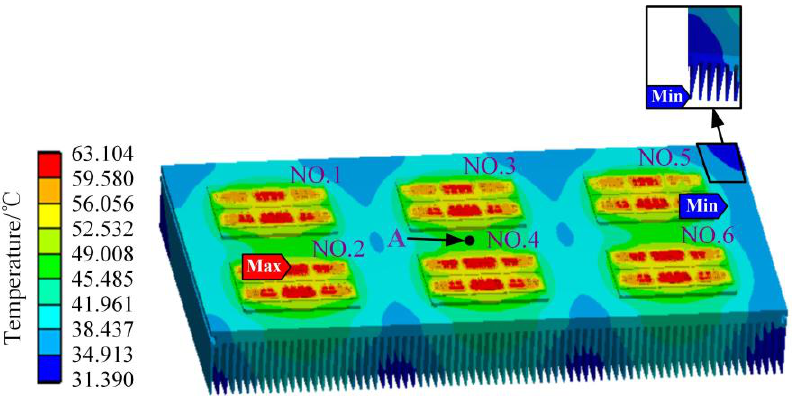
Figure 11. Temperature field of the IGBT module and the heat-sink in the traction converter.